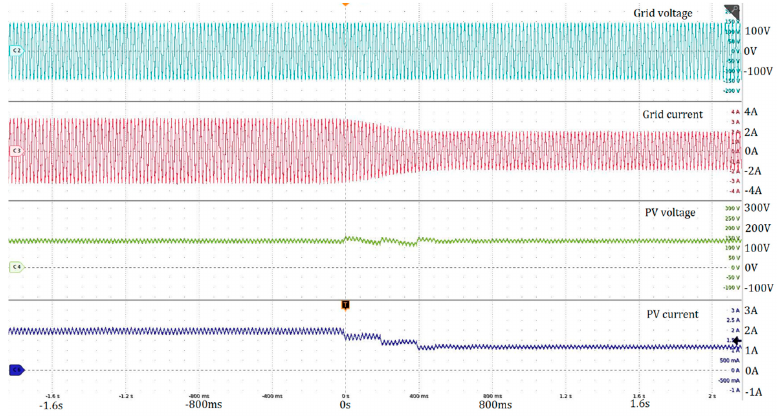
Figure 14. Responses of grid-connected and PV-connected inverters under MPPT control when the resistor R changes from 60 W to 100 W.